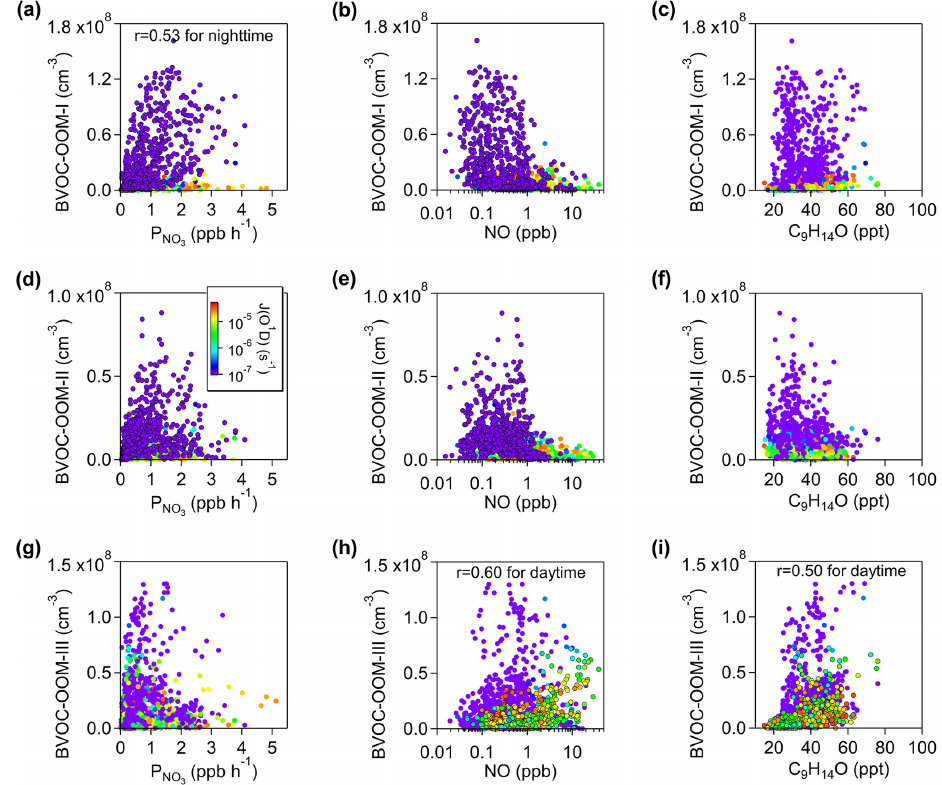
Figure 10. Scatterplots of the BVOC-OOM-I factor with (a) P NO , (b) NO, and (c) nopinone (C 9 H 14 O). Scatterplots of the BVOC-OOM- 3 II factor with (d) P NO , (e) NO, and (f) nopinone (C 9 H 14 O). Scatterplots of the BVOC-OOM-III factor with (g) P NO , (h) NO, and (i) 3 3 nopinone (C 9 H 14 O). All the dots are colored by J( O 1 D ) to show the difference between day and night. The Pearson correlation coefficient shown in (a) is calculated for the nighttime, but the correlation coefficients in (h) and (i) are only for the daytime. icals are also reported in the CLOUD chamber (Yan et